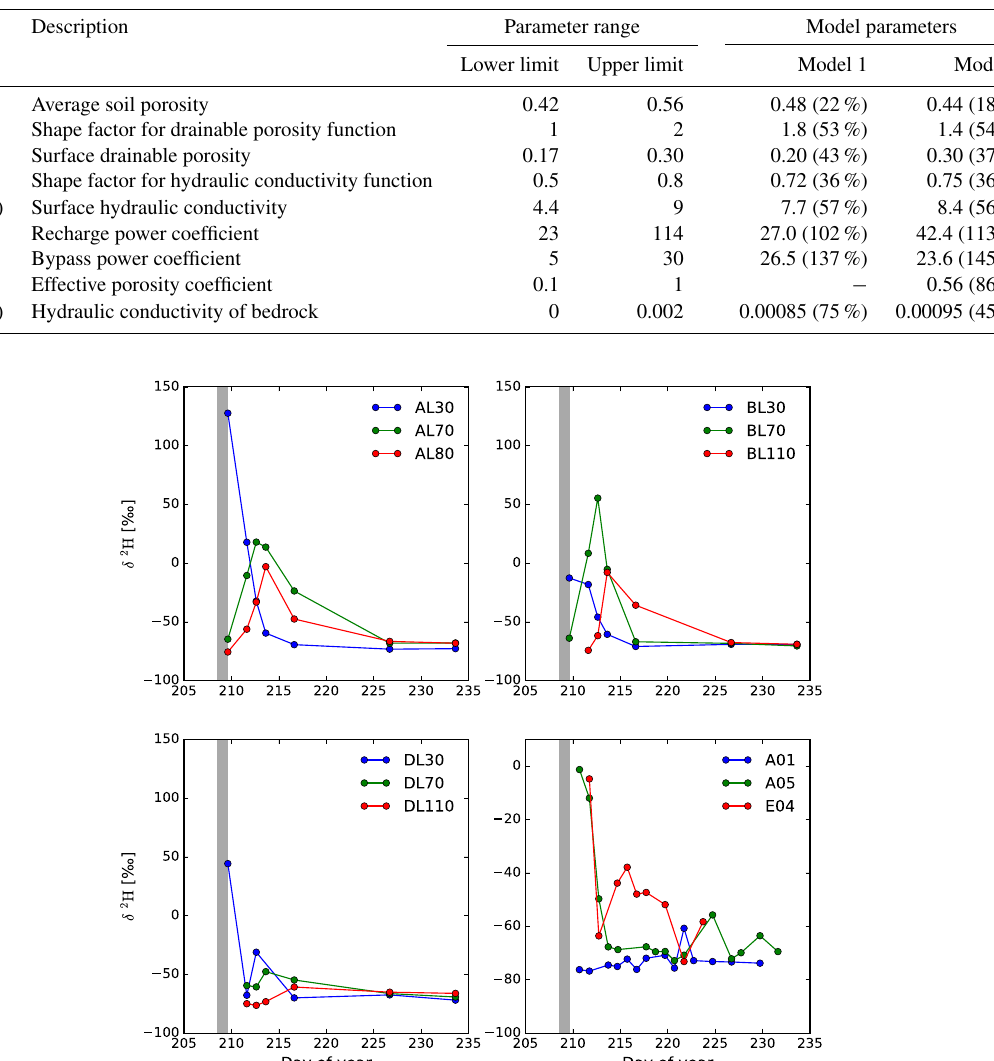
Figure 4. Soil water δ 2 H breakthrough curves at tension lysimeter nests AL, BL and DL, and wells A01, A05 and E04. The gray area represents application of labeled irrigation